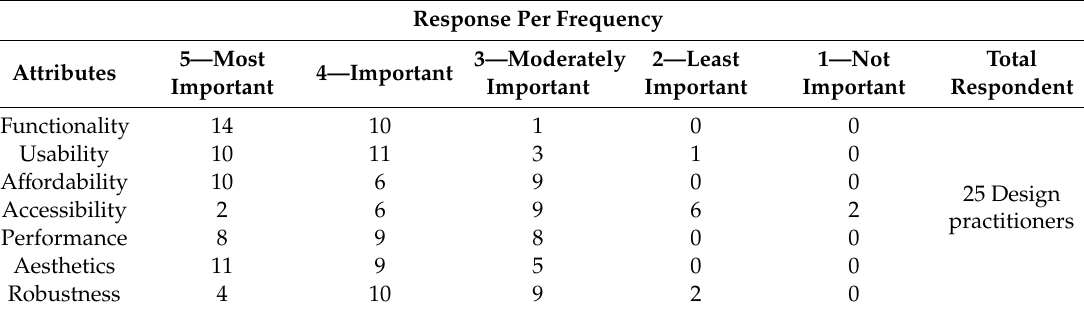
Table 4. Factors a ff ecting designing of a frugal innovation (design practitioner responses).